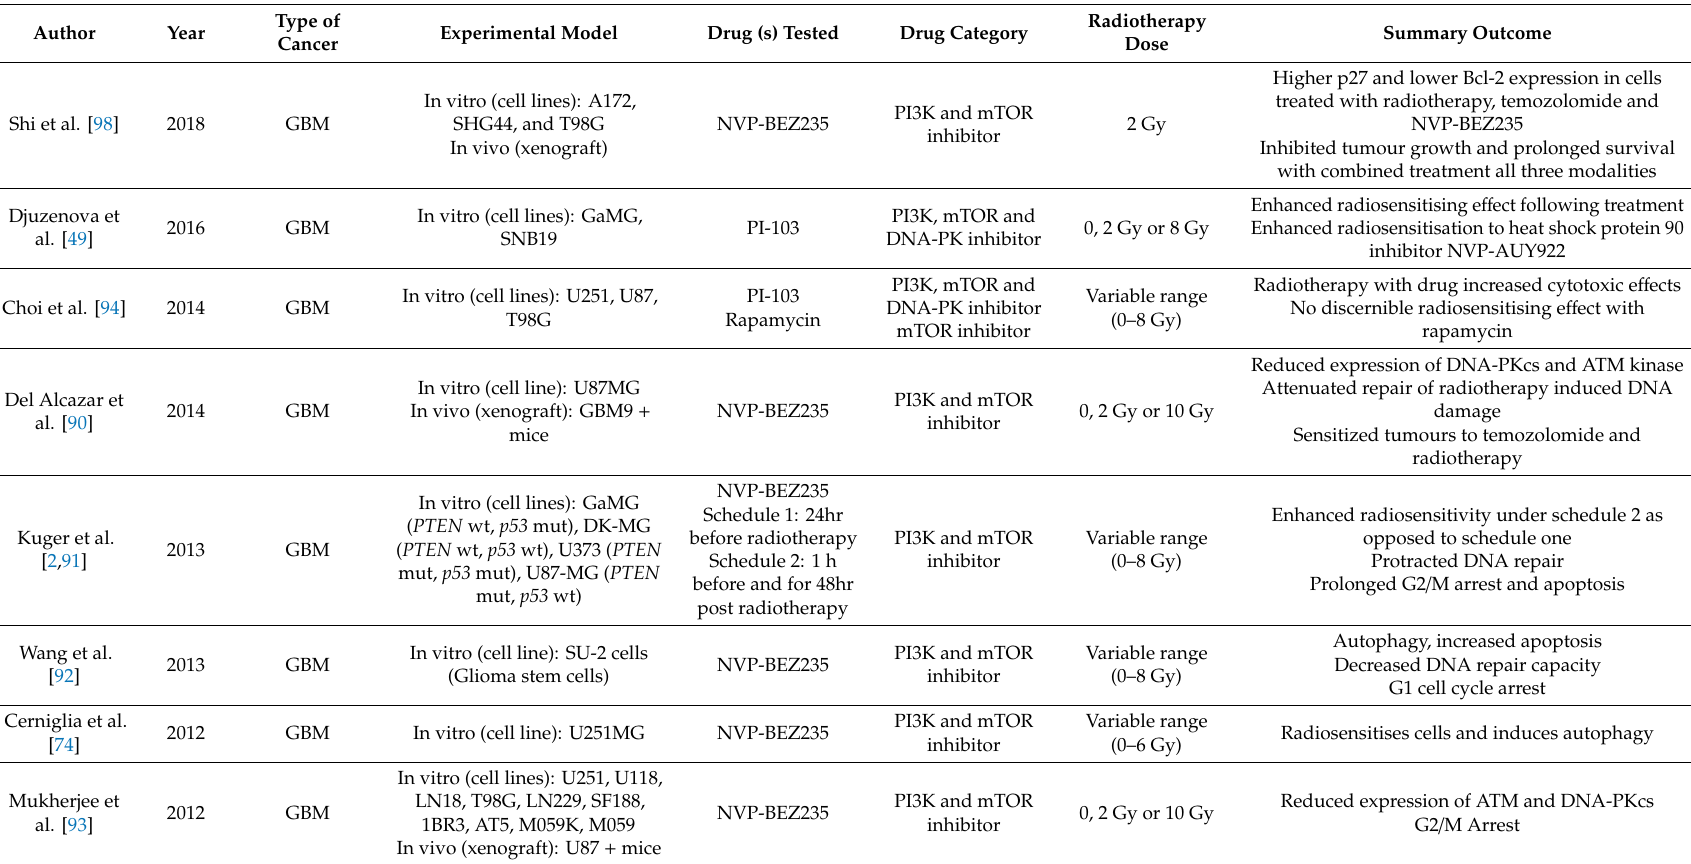
Table 3. Preclinical studies exploring the role of PI3K, AKT and / or mTOR inhibitors radiosensitising